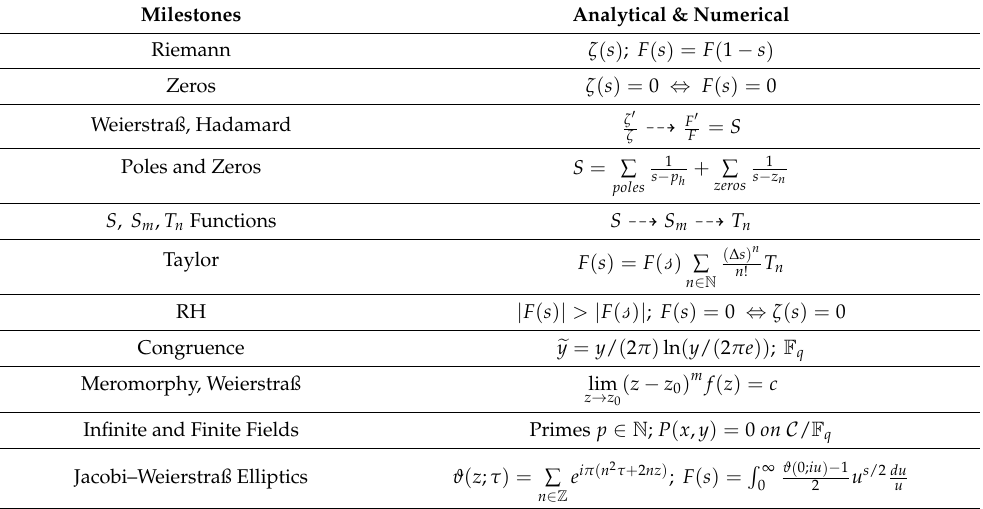
Table 2. Flowchart of the process with the main